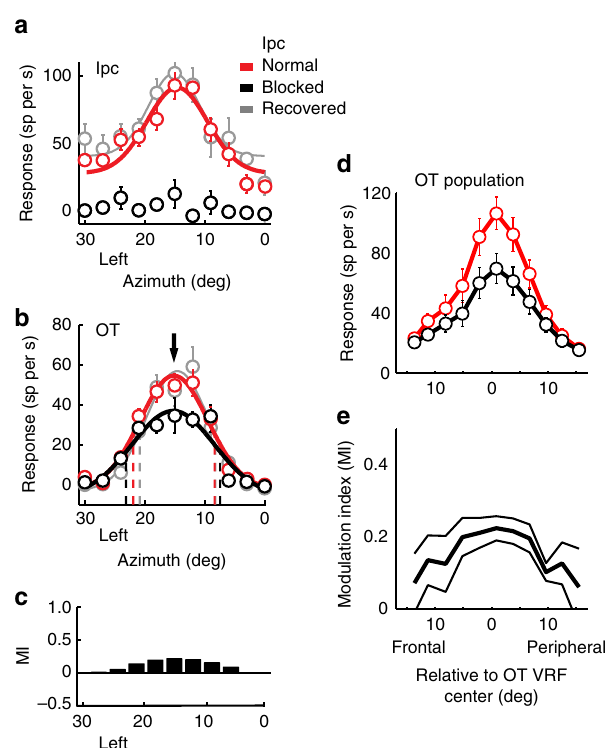
Figure 2 | Effect of Ipc blockade on spatial tuning at aligned sites in the Ipc and OT. ( a ) Data from a multi-unit recording at the Ipc injection site. ( b ) Data recorded simultaneously from a single OTunit at an aligned site in the OT. Responses to a dark looming dot (full contrast; 8 (cid:2) per s) at different locations across the visual field were measured before, during and after iontophoretic application of kyn at the Ipc site. Symbols represent mean and s.e. ( n ¼ 12); dashed vertical lines indicate locations of half-max responses; curves are best-fit Gaussian functions. Downward arrow indicates the Ipc VRF centre, measured in a . ( c ) Response modulation index (MI; Methods) calculated from the Gaussian fits for the responses shown in b . ( d ) Population average and s.e.m. of the responses of OTunits from aligned OT–Ipc pairs ( n ¼ 28) tested as described in b . The data are plotted in degrees frontal versus peripheral relative to the VRF centre. ( e ) Population average MI and s.e.m. resulting from Ipc blockade for OTunits from aligned OT–Ipc pairs ( n ¼ 28).